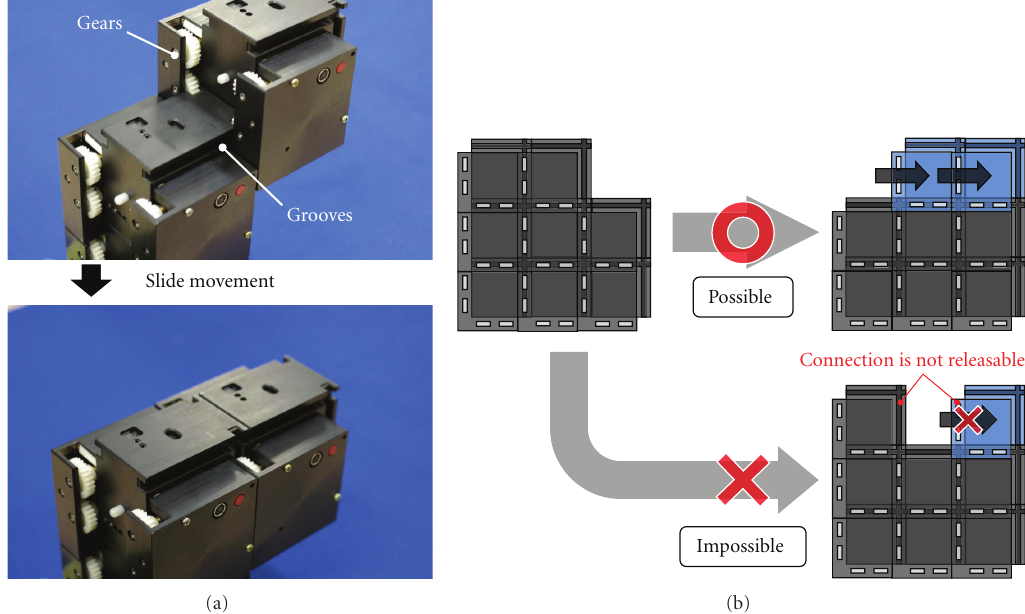
Figure 4: Structural transformation of CHOBIE II (a) connection of the modules by slide motion, (b) mechanical constraint in transformation.